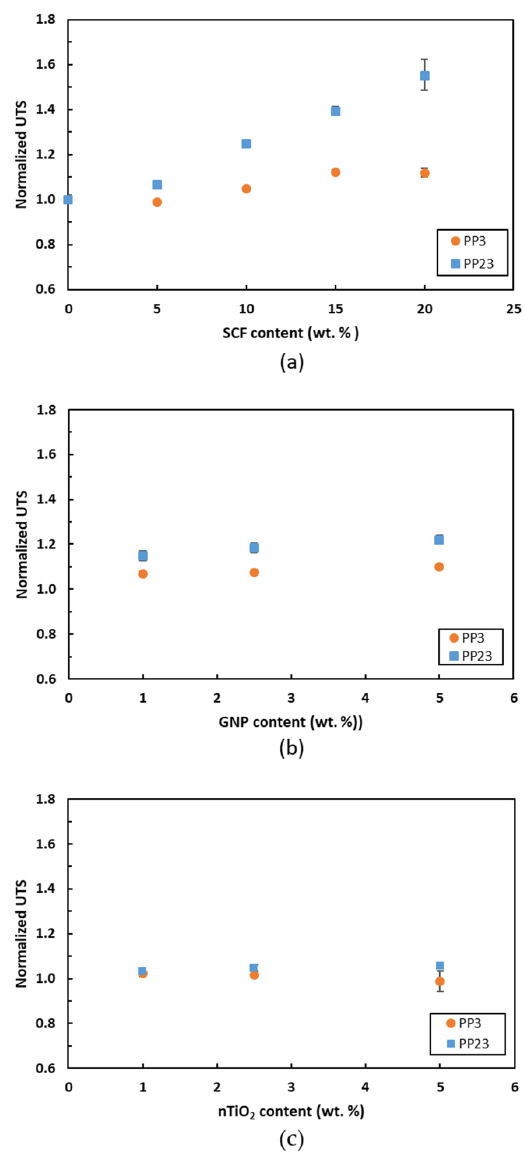
Figure 11. Normalized UTS of ( a ) PP/SCF, ( b ) PP/GNP, and ( c ) PP/nTiO 2 composites.